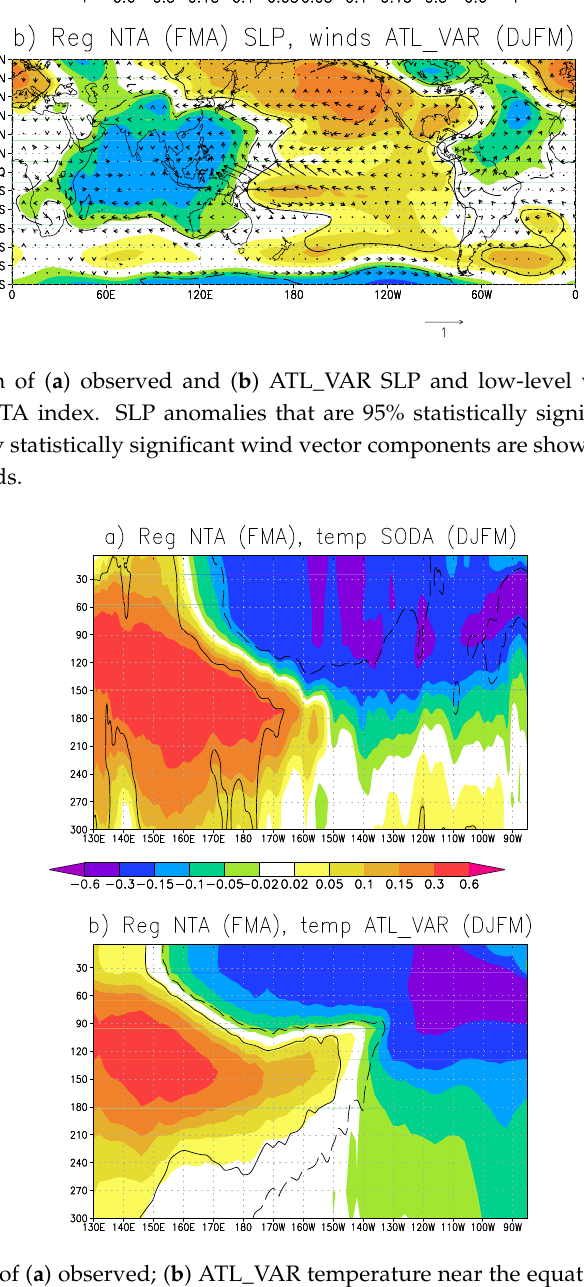
Figure 6. Regression of ( a ) observed; ( b ) ATL_VAR temperature near the equator (DJFM; averaged from 5 ◦ S to 5 ◦ N) onto the preceding (FMA) NTA index. Anomalies that are 95% statistically significant are indicated by contours. Units are